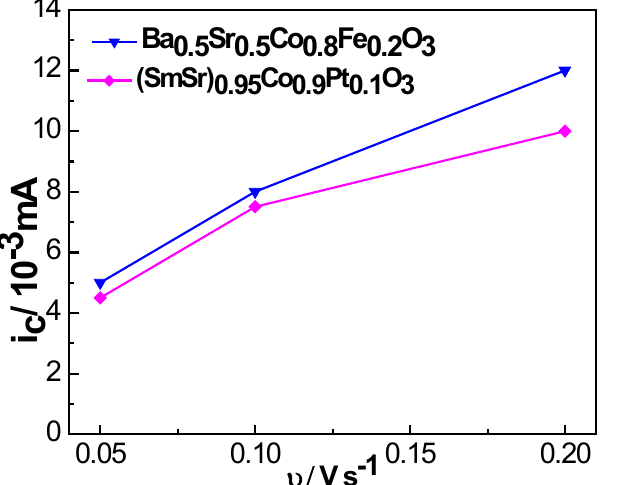
Figure 7. Anodic charging currents measured at 0.01 V plotted as a function of scan rate for (SmSr) 0.95 Co 0.9 Pt 0.1 O 3 and Ba 0.5 S r0.5 Co 0.8 Fe 0.2 O 3 powders in 0.1M KOH solution.